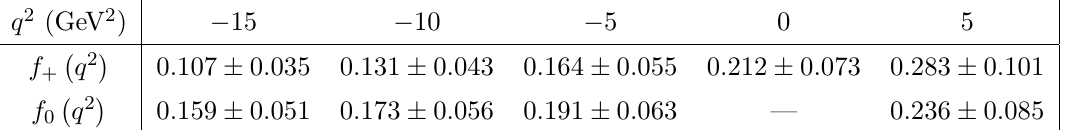
Table 5 . Updated LCSR inputs at values of q 2 other than zero [14] the corresponding correlations are given in table